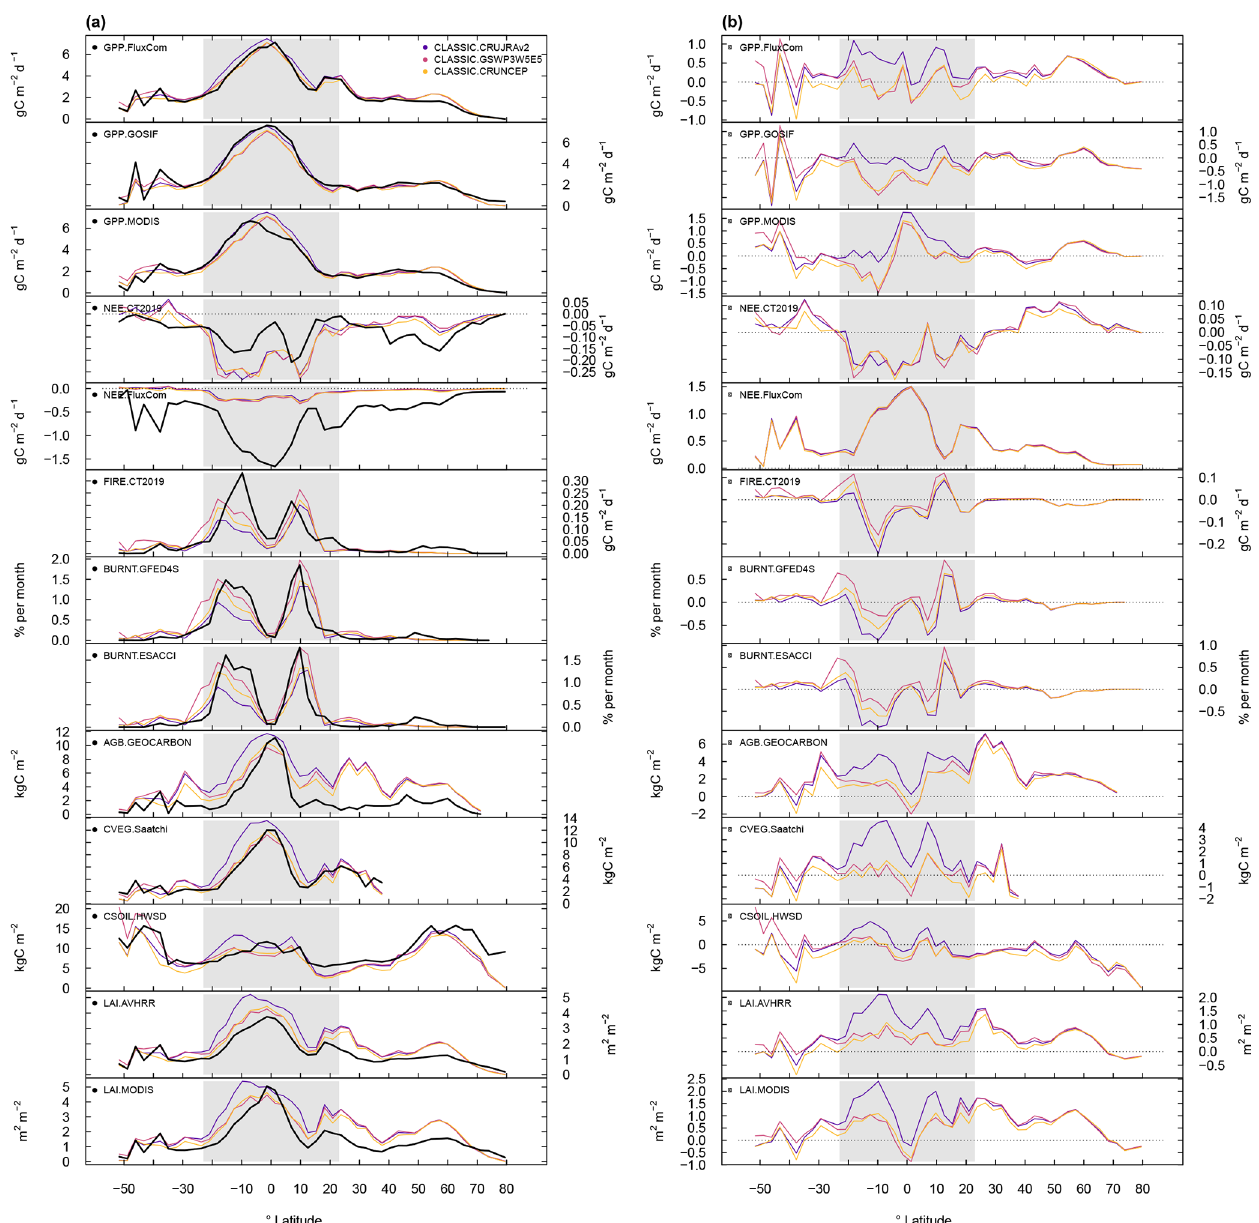
Figure 12. (a) Zonal mean values and (b) corresponding biases for variables related to the carbon cycle.